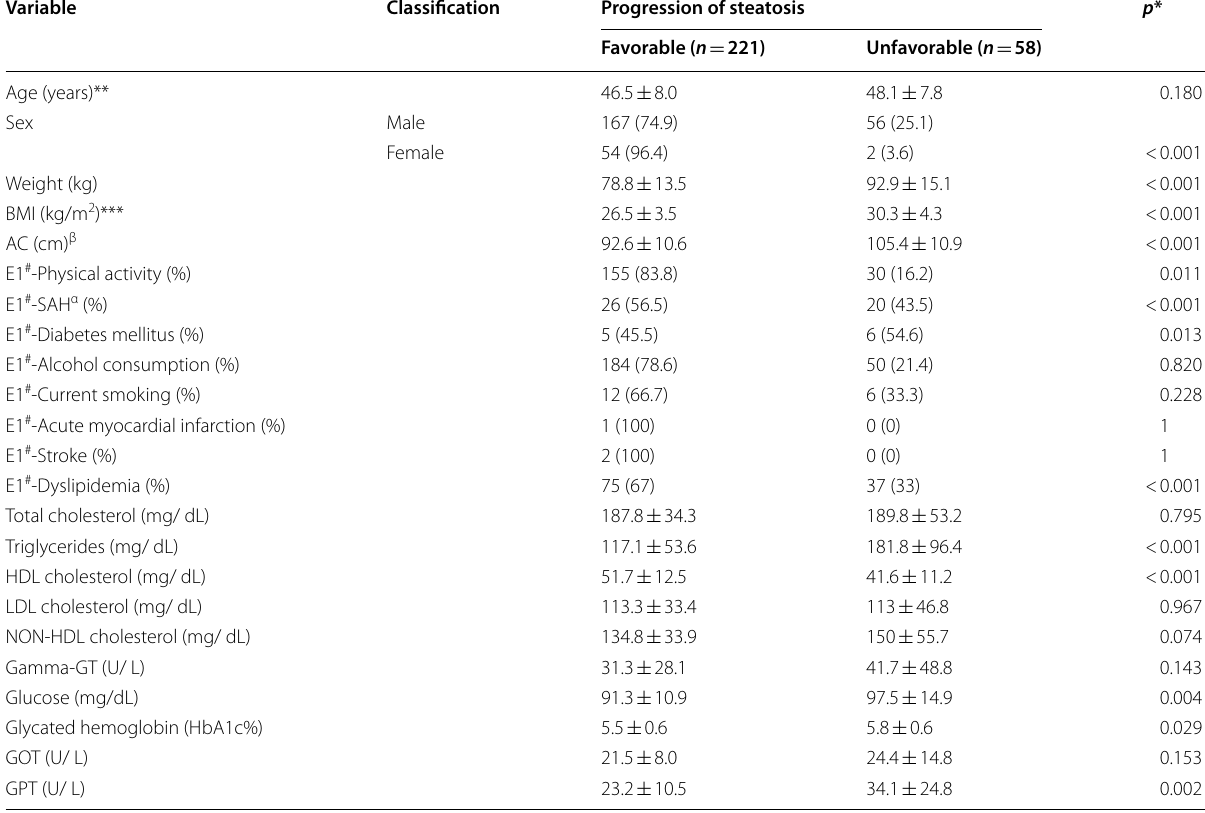
Table 2 Progression of steatosis and demographic and clinical variables in the first